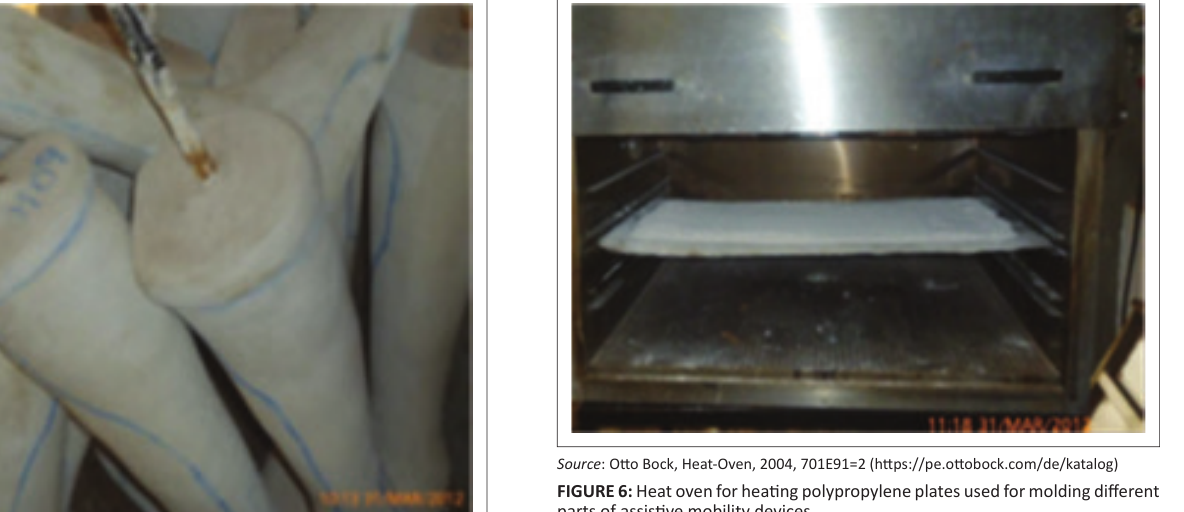
FIGURE 6: Heat oven for heating polypropylene plates used for molding different parts of assistive mobility devices.